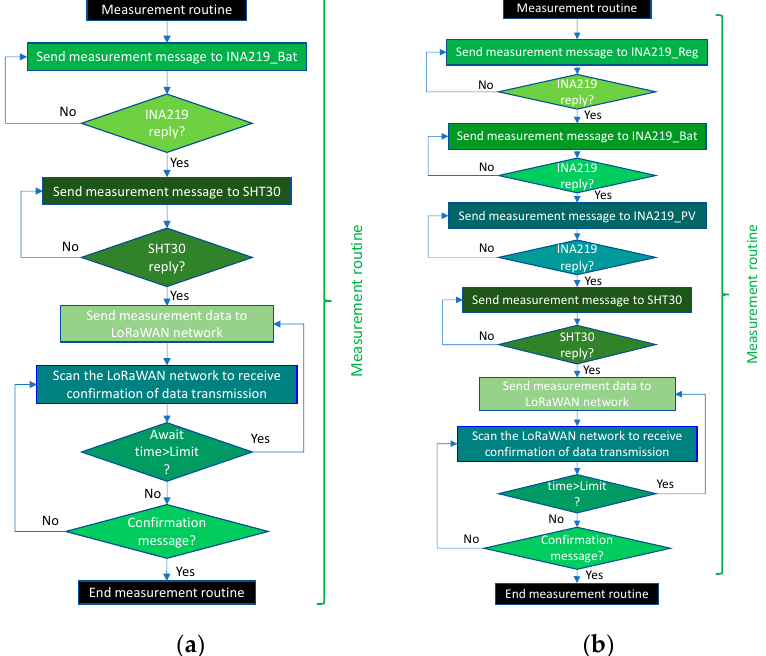
Figure 13. Flow chart of the measurement routines for the THMDL: ( a ) battery power supply and ( b ) battery and solar panel power supply.